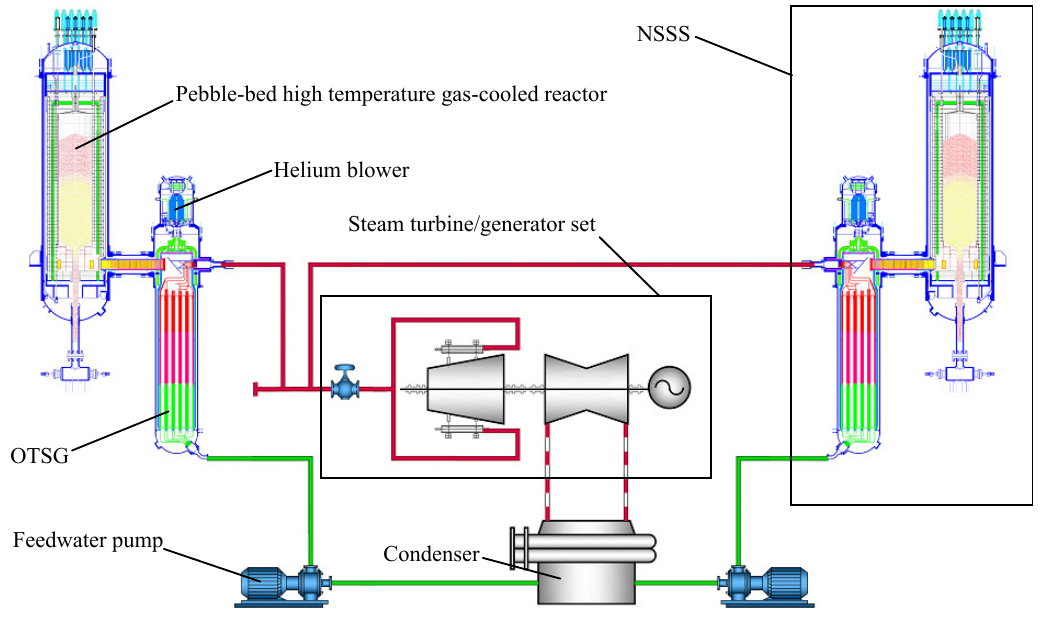
Figure 1. Schematic structure of the HTR-PM power